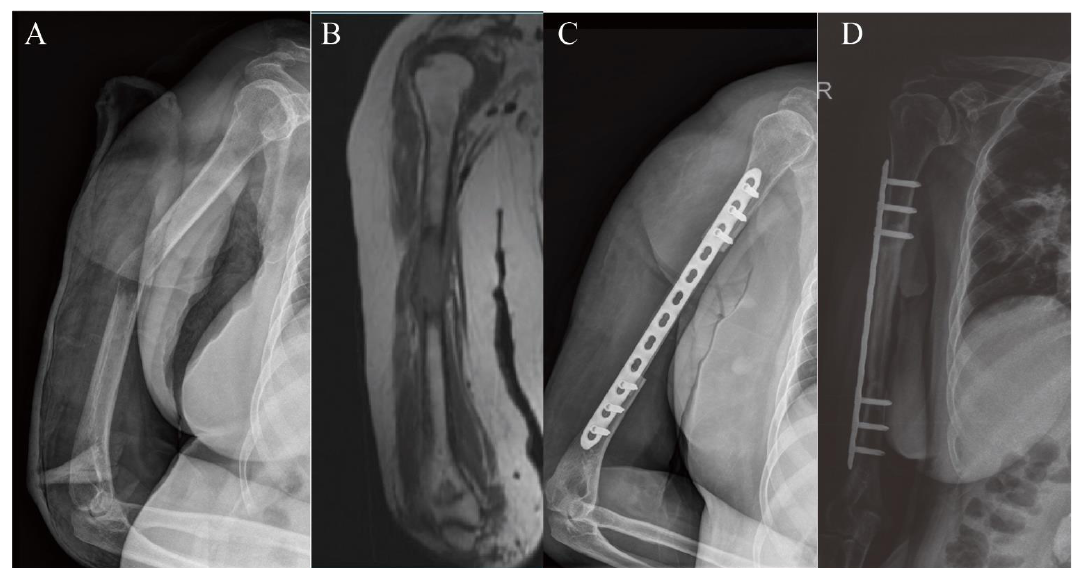
Figure 3. A patient underwent humerus diaphyseal reconstruction. ( A , B ) A female patient, aged 61 years, was histologically diagnosed with bone metastasis of thyroid carcinoma located in the right humerus. The tumor was examined by both X-ray and magnetic resonance imaging. ( C ) Photograph showing reconstruction with the fibular graft inserted into the medullary canal of the autograft and fixation with a single plate. ( D ) Radiograph showing primary union five months after surgery.